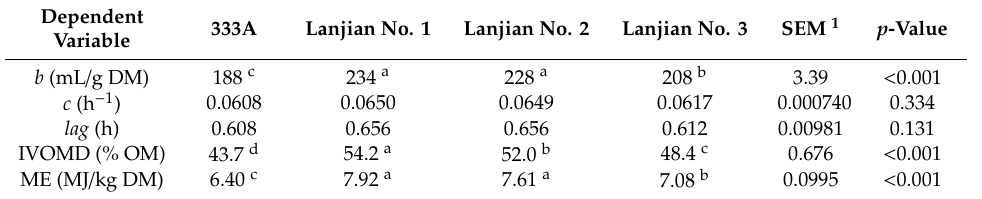
Table 5. Influence of variety on gas production parameters, in vitro organic matter digestibility (IVOMD) and metabolizable energy (ME) of straw in four common vetch